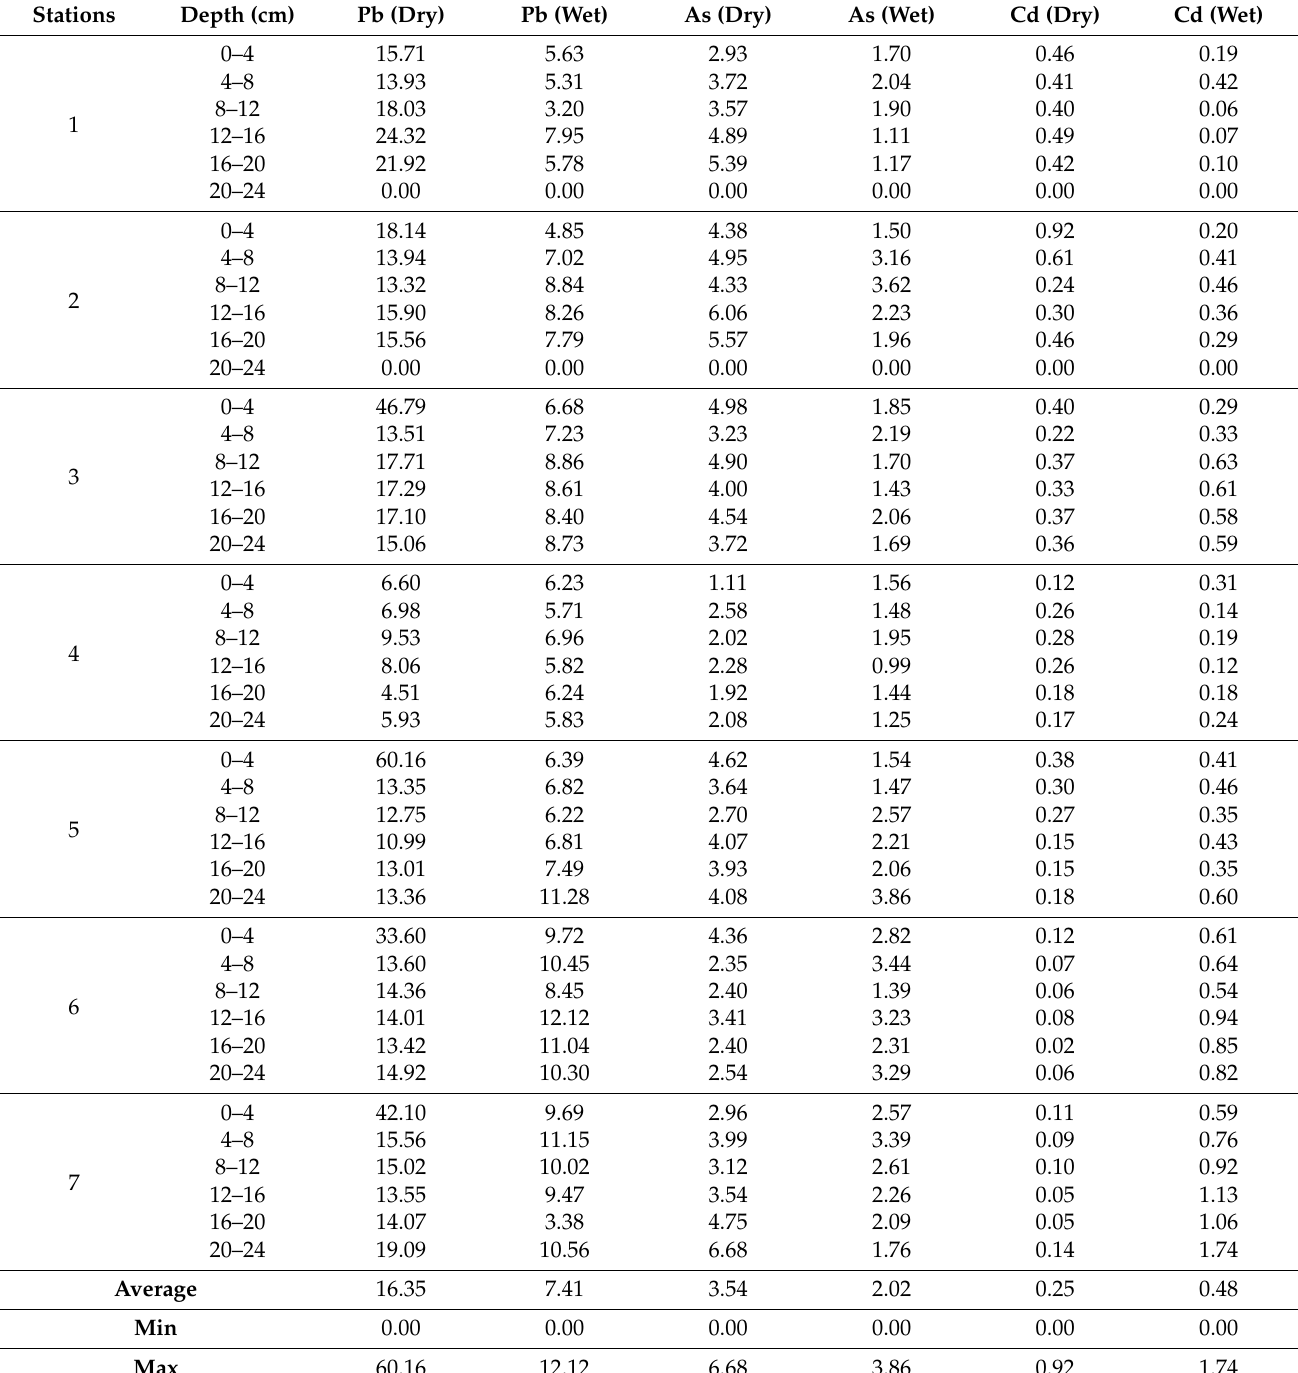
Table 2. Heavy metal concentrations (mg/kg dry weight) in the sediment cores of the Khuan Khi Sian